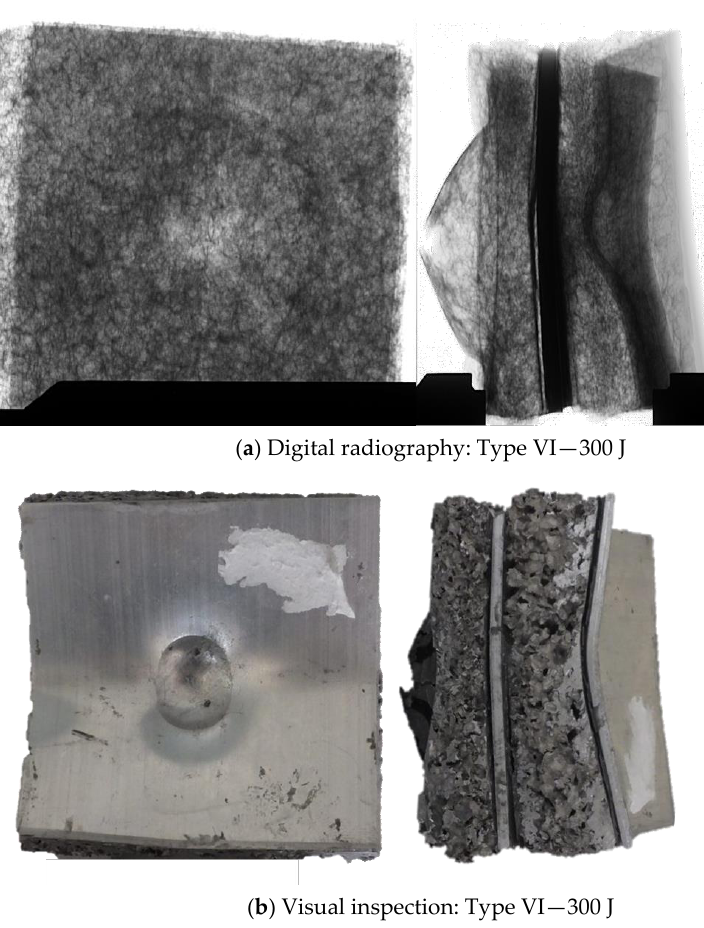
Figure 12. ( a ) Radiographic and ( b ) visual inspections for Type VI specimen subjected to an energy impact of 300 J.